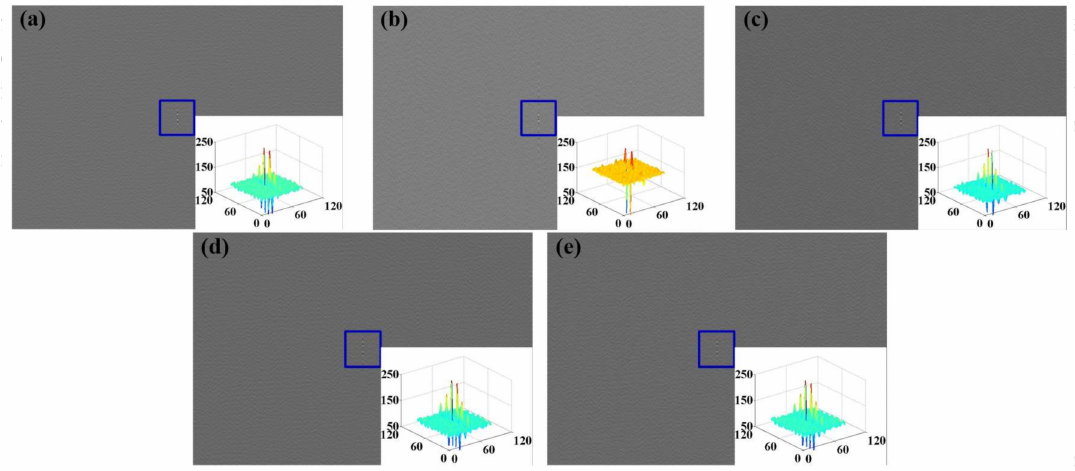
Figure 7. T-maps of test gases ( a ) NO 2 ( b ) SO 2 ( c ) NO 2 + SO 2 ( d ) C 6 H 6 ( e ) C 7 H 8 .